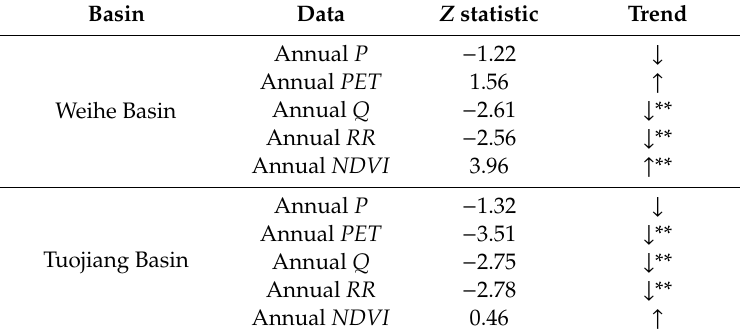
Table 3. Mann-Kendal (MK) test results of the annual hydro-meteorological data series, the annual runo ff ratios and the annual NDVI data series for Weihe Basin and Tuojiang Basin. The critical value of the MK statistic is Z 1 − α /2 = 1.960 with α = 0.05.